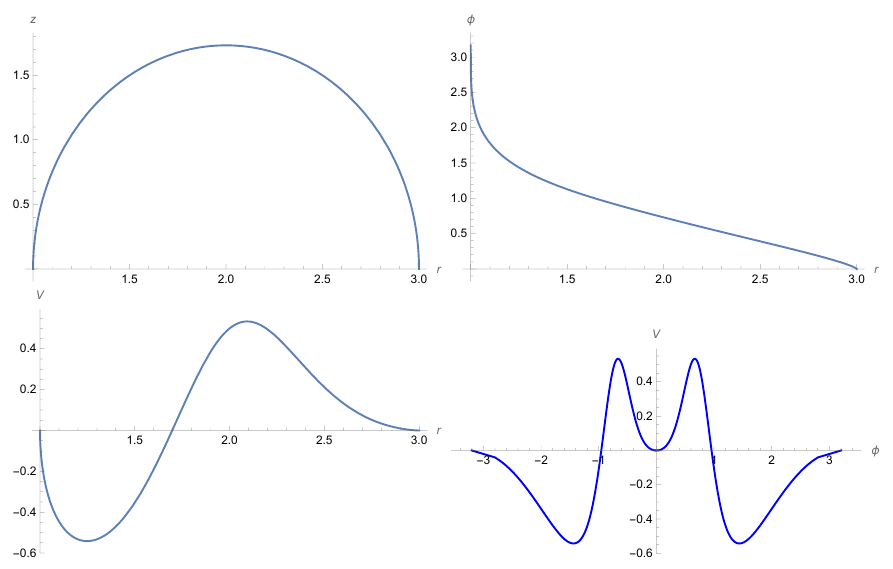
√ Figure 16 . The 3 -stretched configuration of figure 15. The quadratic coefficients of V ( φ ) are − 0 . 25 at r = 1 and 0 . 75 at r = 3